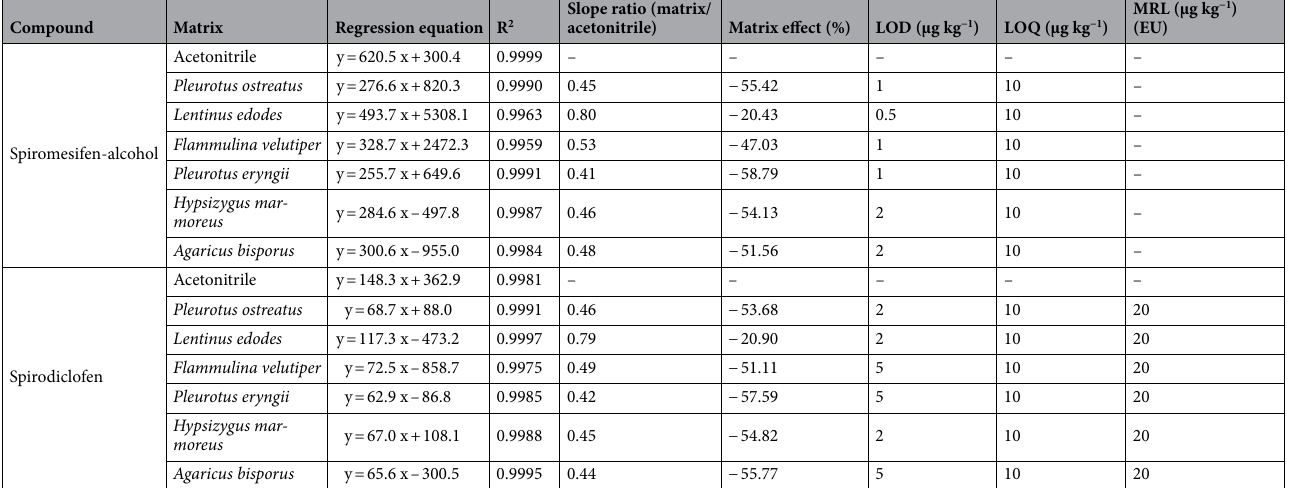
Table 2. Calibration equations, R 2 , LOD, and LOQ of the target compounds in edible fungi. Matrix effect (%) = ((slope matrix/slope solvent) − 1) × 100.